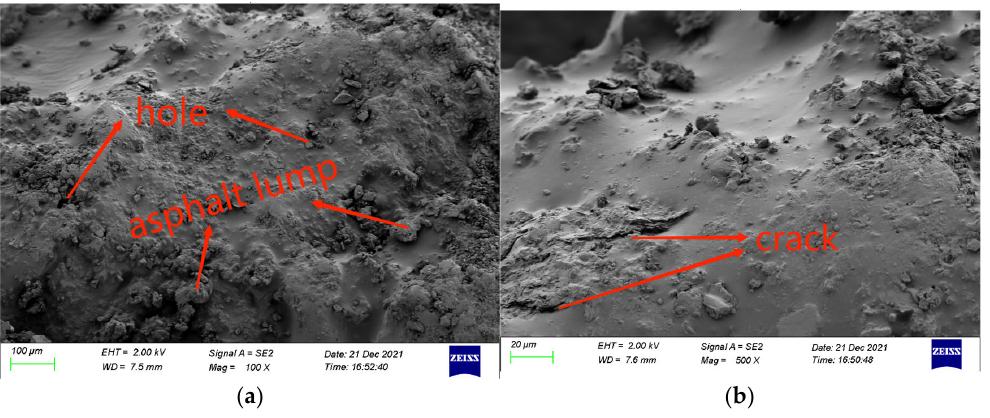
Figure 10. Microscopic morphology of PCRM mixture with 60% RAP dosage. ( a ) Ampli fi ed factor 100. ( b ) Ampli fi ed factor 500.